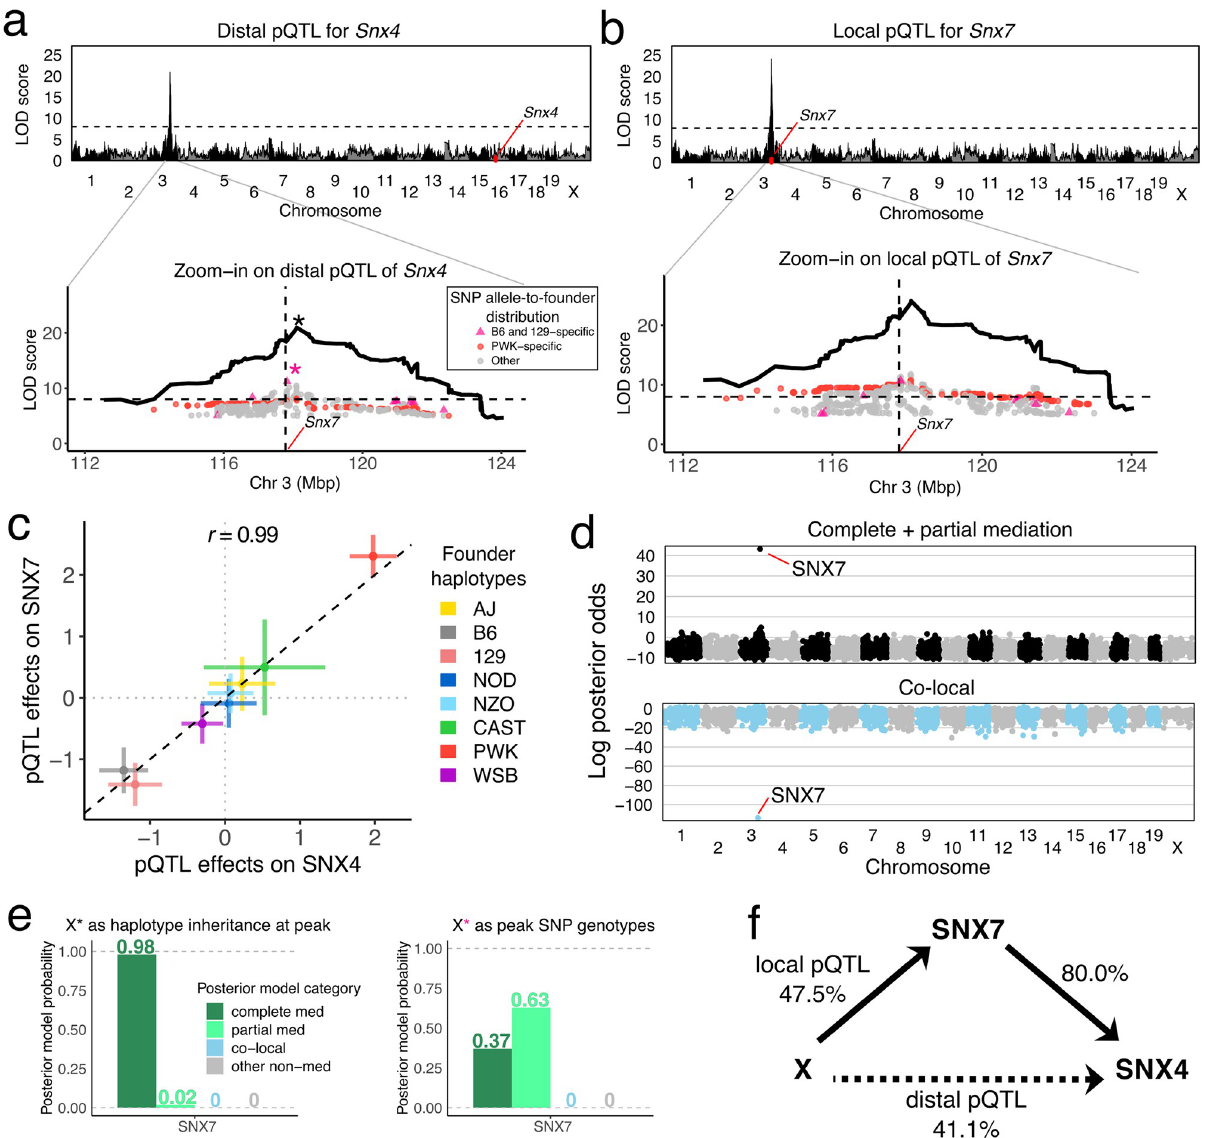
Fig 6. Mediation analysis of a distal pQTL for Snx4 in DO mice. Genome-wide LOD scores for associations of (a) SNX4 and (b) SNX7 abundance were performed using founder haploptye linkage mapping. Zooming into the QTL region, LOD scores for variant association within the pQTL region (peak ± 5 Mbp) for bi-allelic vartiants with LOD scores > 5 are overlaid on the haplotype association LOD curve. Variants with alleles specific to B6 and 129 (pink) and PWK (red) are highlighted. (c) The founder haplotype effects at the pQTL are multi-allelic and highly similar for the two proteins. (d) Genome-wide mediation scan where all observed proteins are individually evaluated as mediators of the Snx4 distal pQTL highlights SNX7 as a mediator (complete and partial summed) and strongly indicates that the co-local model is unlikely. Each point represents the log posterior odds for a candidate mediator for the specified mediation model. (e) Posterior probabilities of mediation models for the pQTL (left) using founder haplotypes and (right) using the peak bi-allelic variant. (f) The complete mediation model with SNX7 as mediator of the Snx4 distal pQTL is shown as a DAG with estimated effect sizes in units of percent variance explained. The dashed line indicates the strength of the distal pQTL that is not included in the model because it is completely mediated.